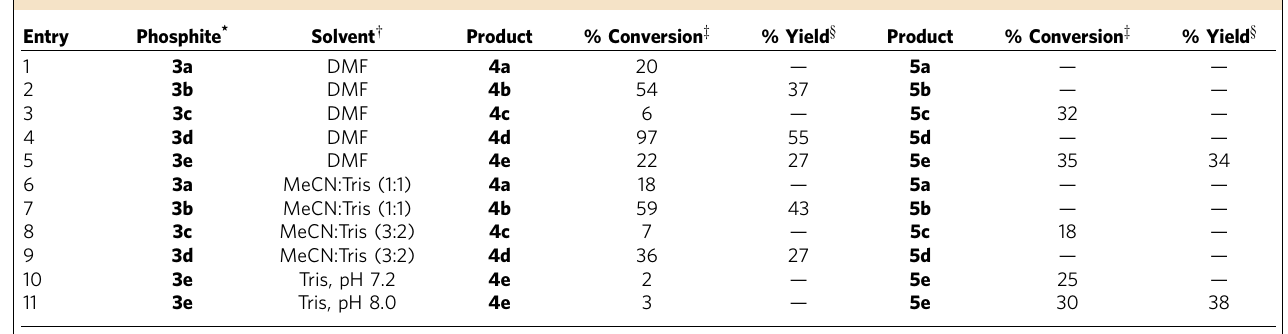
Table 1 | MS-conversion and isolated yields for phosphorothiolate esters peptides 4 and